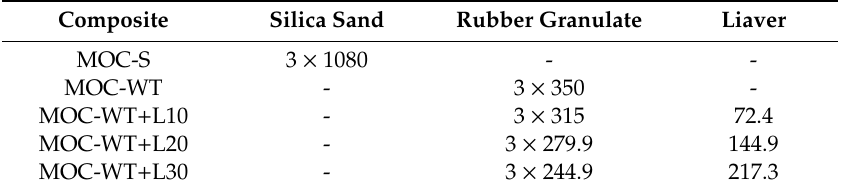
Table 1. The weight proportioning of designed composites (g), the dosage of MgO, MgCl 2 · 6H 2 O, and water was kept constant for all produced mixtures, and was 1350 g, 597.9 g, and 496.8, respectively.